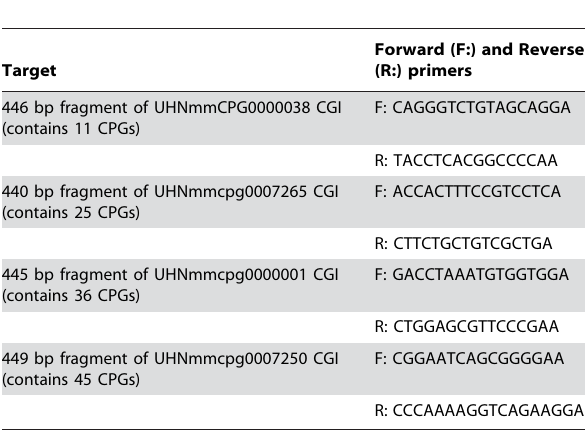
Table 1. PCR probes used in verification of the linearity of MeDIP-based methylcytosine